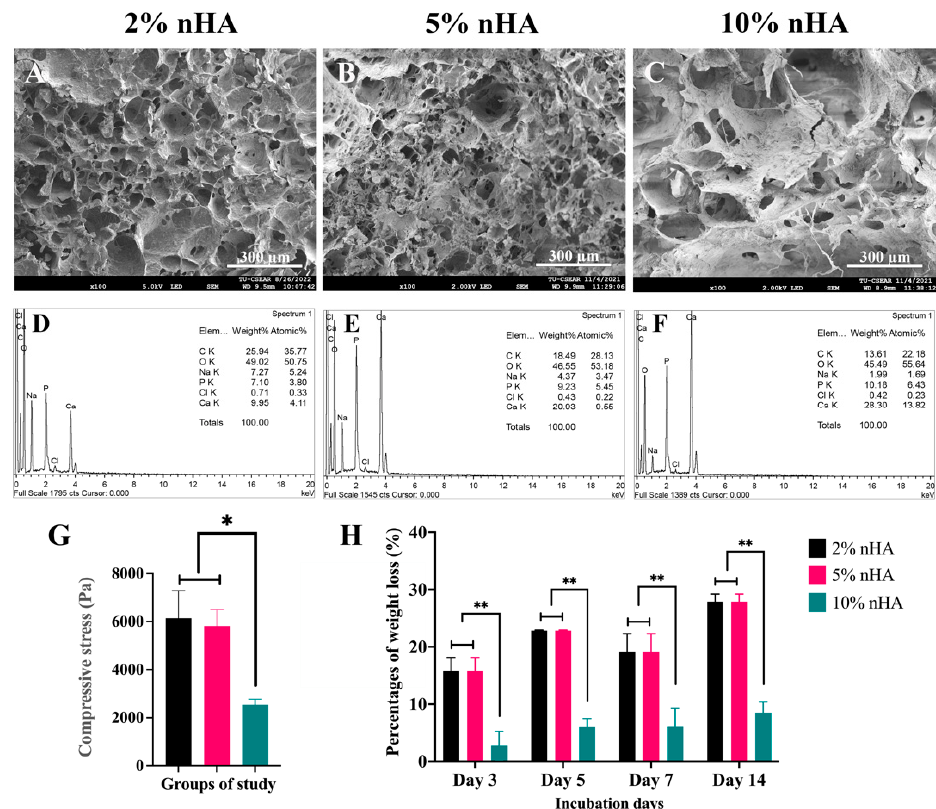
Figure 2. Effects of nanohydroxyapatite particles on microstructures, mineral compositions, mechanical strength, and physical stability of the thermosensitive nanohydroxyapatite–2% ( w / v ) calcium carbonate microcapsule–10% ( w / v ) β -glycerophosphate–4:1 ( w / w ) chitosan/collagen hydrogel (nHA–CaCO 3 –chitosan/collagen). ( A – C ) Scanning electron microscopy images and ( D – F ) energy dispersive X-ray spectroscopy (EDS) of the freeze-dried hydrogels: ( A , D ) 2% nHA, ( B , E ) 5% nHA, and ( C , F ) 10% nHA. ( G ) Compressive strength and ( H ) degradation rates of the hydrogels. The * and ** symbols represent significantly different values with p < 0.05 and p < 0.01, respectively (n = 5, mean ± SD).